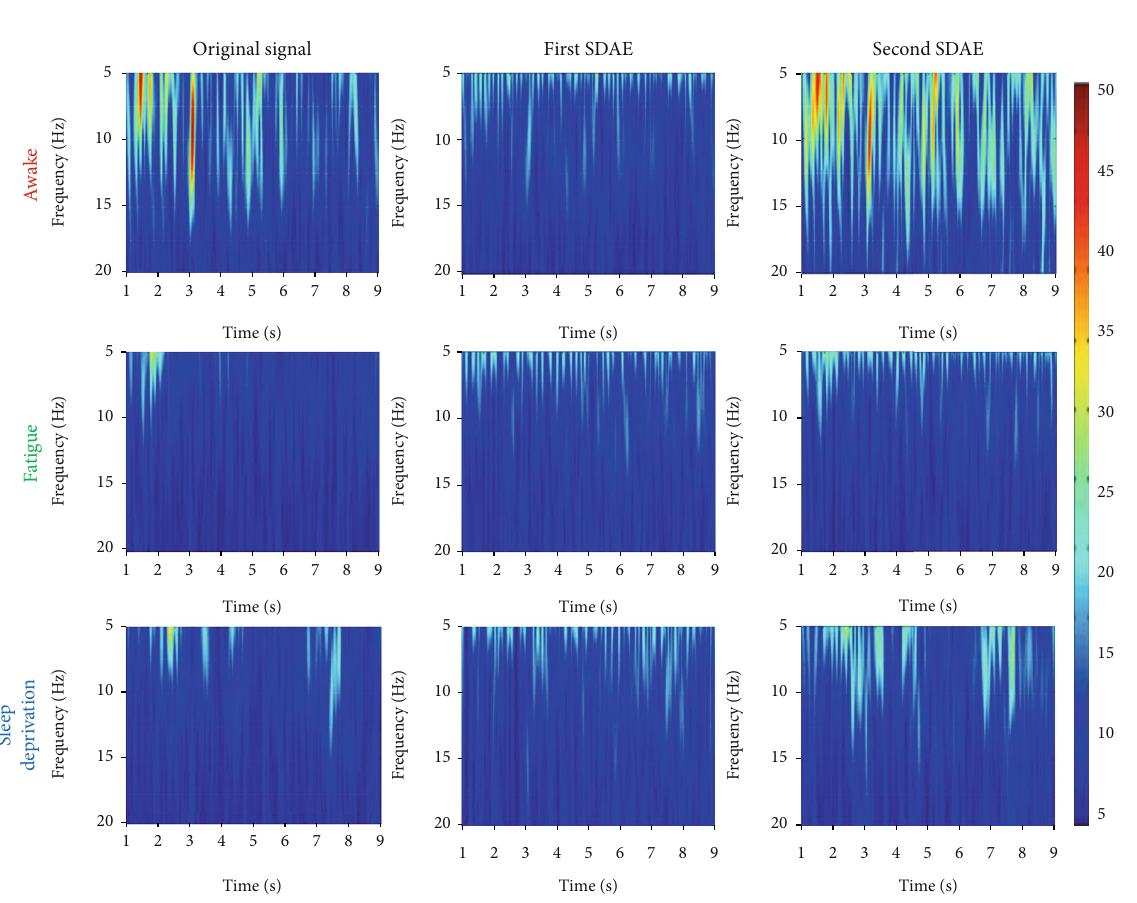
Figure 4: The time-frequency images of the average original signal and the features extracted by the fi rst autoencoder and second autoencoder on area 4 during three